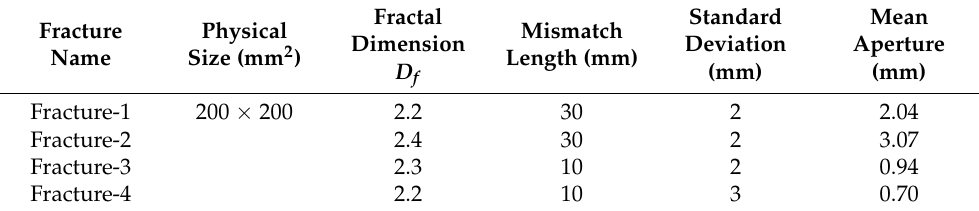
Table 1. Fracture parameters generated by